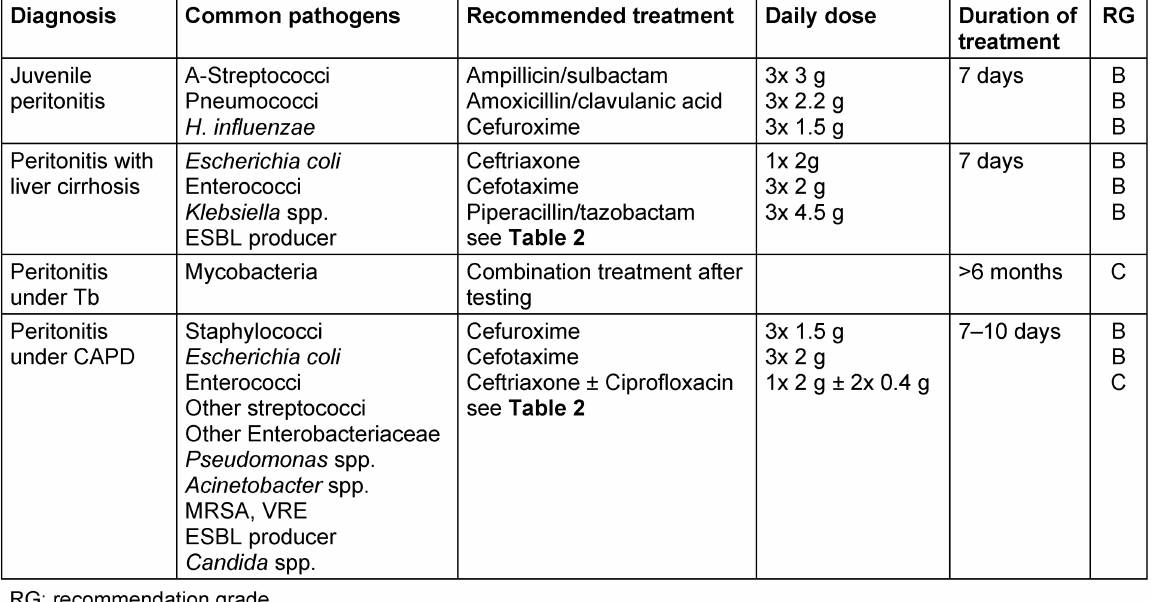
Peritonitis under